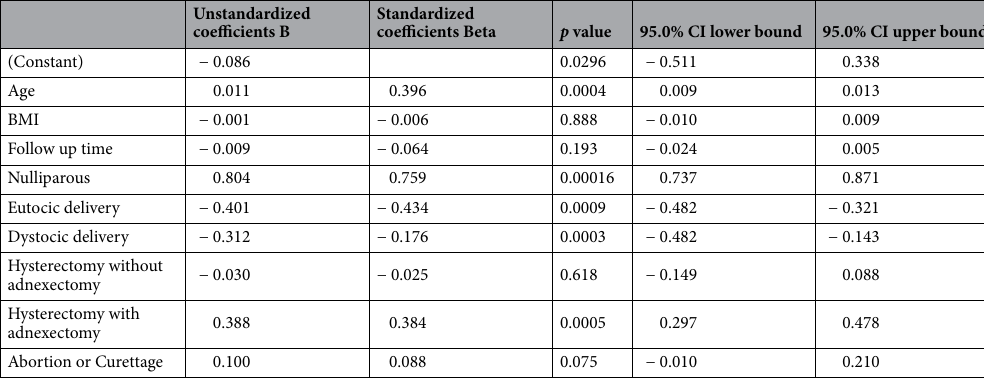
Table 2. Mutiple regression between the RUTI and the variables, positive or negative correlations of the variable on a global sample.